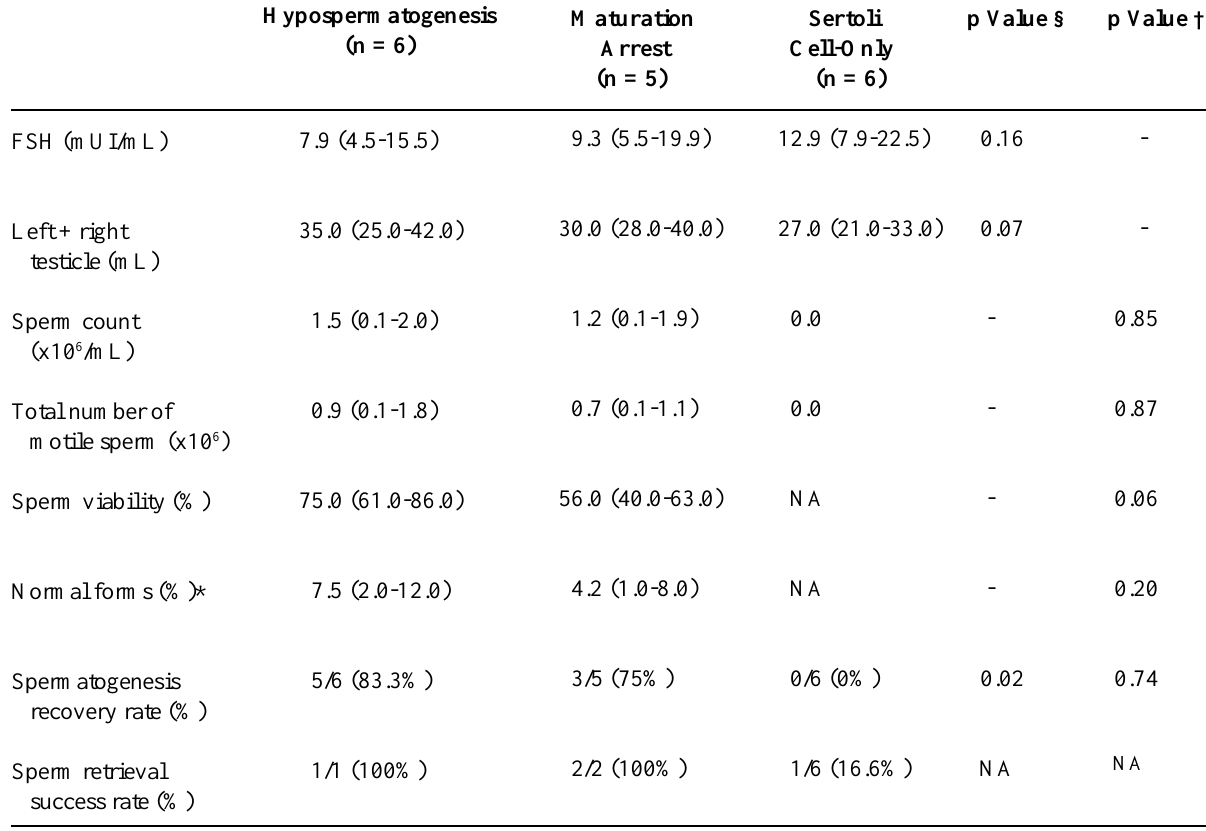
Table 1 – Follicle-stimulating hormone levels (FSH), testicular volume, postoperative semen parameters, spermatogen- esis recovery and sperm retrieval success rates in patients with testicular histology diagnosis of hypospermatogenesis (HYPO), maturation arrest (MA) and Sertoli-cell only